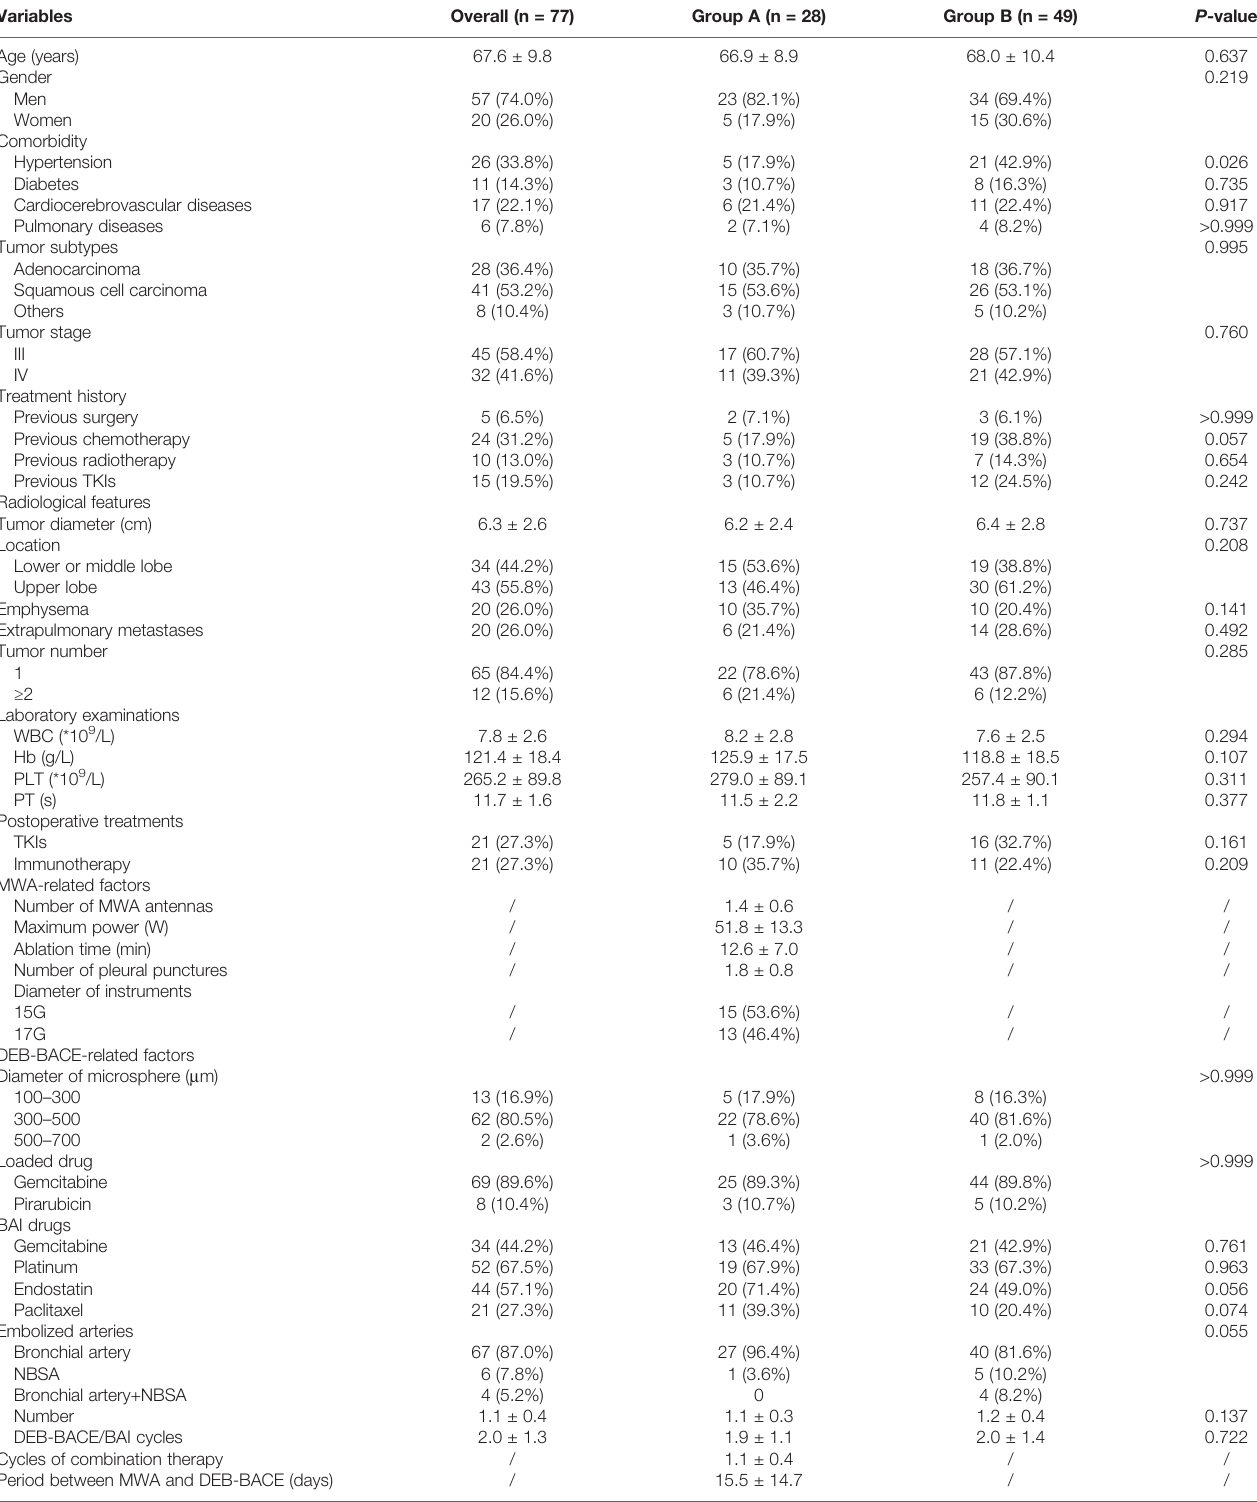
TABLE 1 | Clinical characteristics between ASTRI-NSCLC patients in groups A and B.